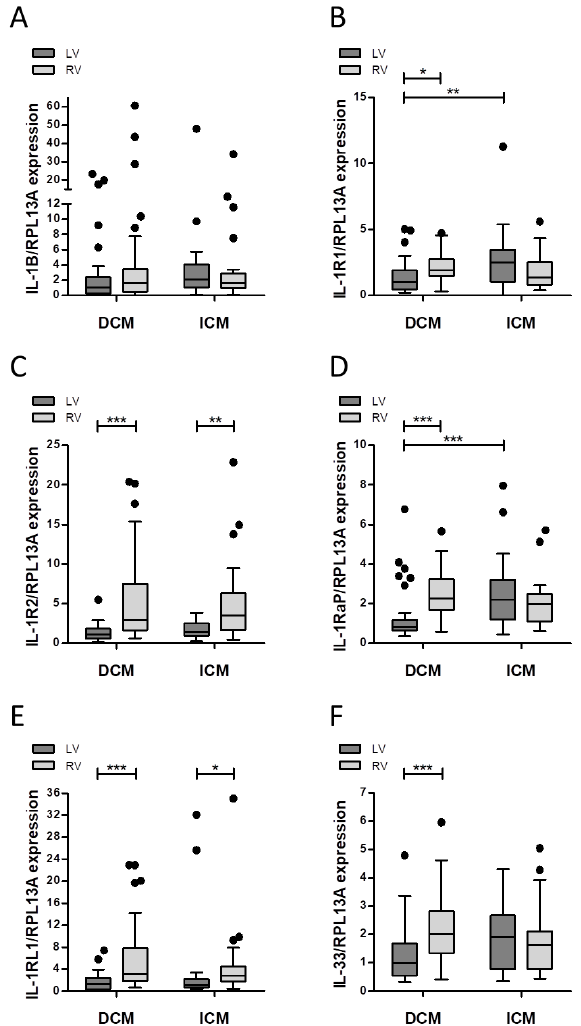
Figure 3. Decreased left ventricular expression of IL-1R1 and IL-1RaP in dilated cardiomyopathy (DCM) versus ischemic cardiomyopathy (ICM). Expression levels of ( A ) IL-1B , ( B ) IL-1R1 , ( C ) IL-1R2 , ( D ) IL-1RaP , ( E ) IL-1RL1 and ( F ) IL-33 are compared for left (LV) and right ventricular (RV) myocardium of patients with heart failure (HF) or left ventricular assist devices (LVAD) support. Data are presented as boxplots with whiskers (Tukey method). Data were analyzed with Kruskal-Wallis Test and Dunn’s post-hoc test (* p < 0.05, ** p < 0.01, *** p < 0.001).